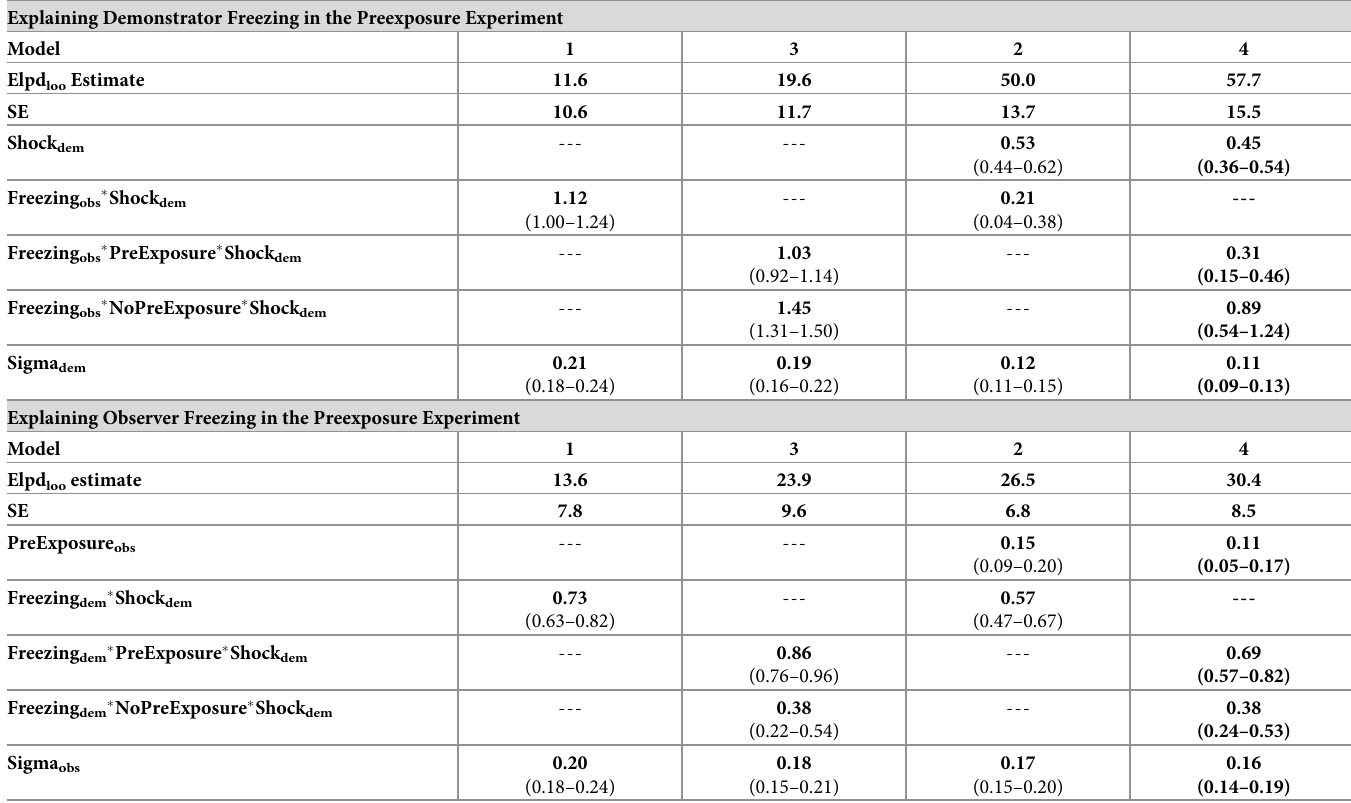
Table 2. Model comparisons for the preexposure